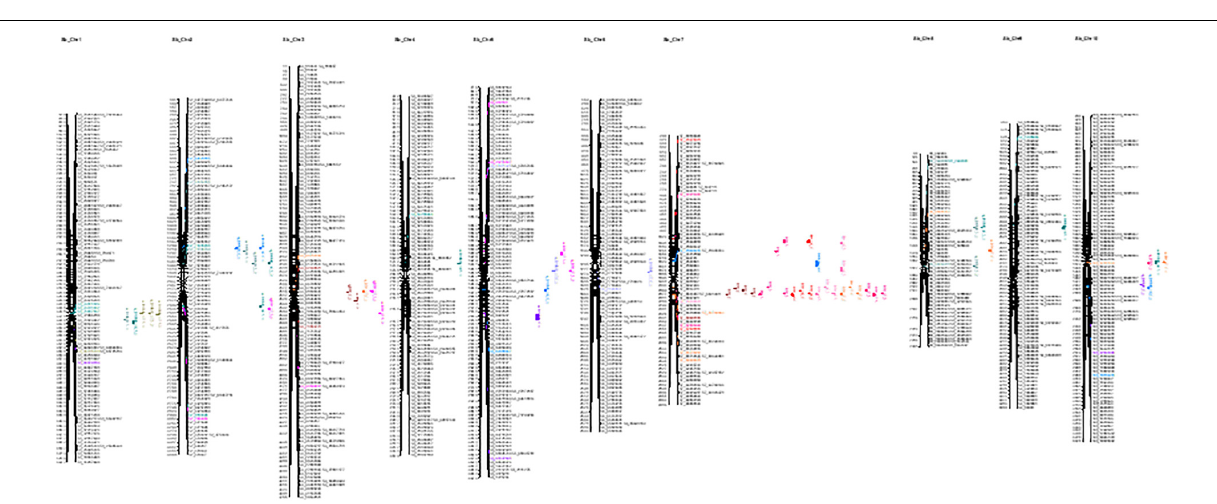
FIGURE 2 | Graphical representation of linkage groups on chromosome for all dry weight and IVOMD under control and drought treatments for 2